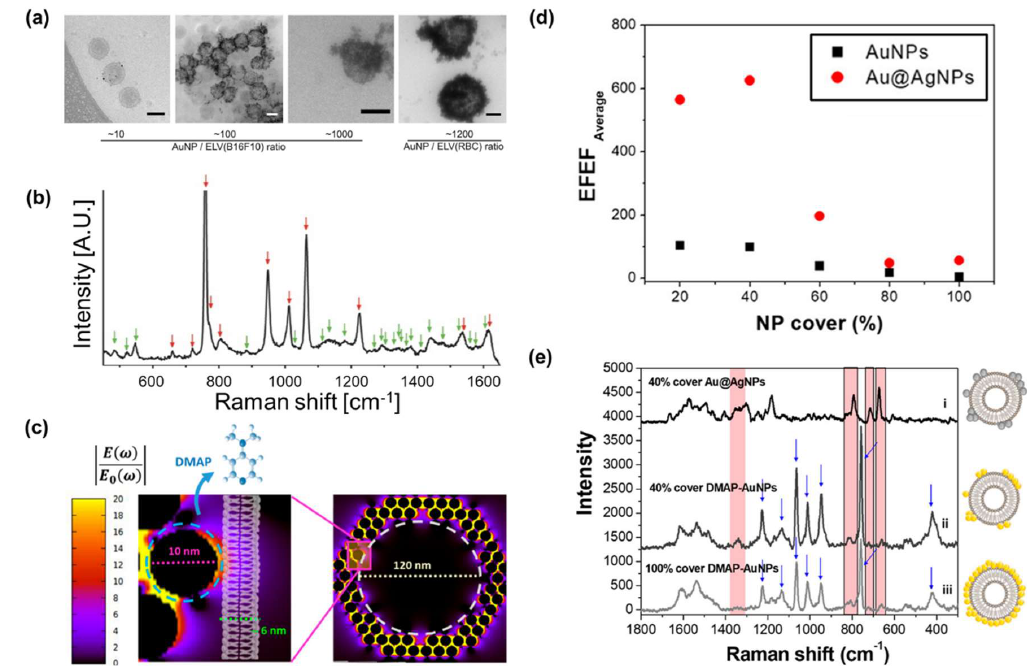
Figure 6. Positively charged particle-based EVs detection ( a ) TEM images of DMAP-AuNPs-coated EVs by each ratio. The scale bars represented 100 nm. ( b ) SERS measurements of DMAP-AuNP coated EVs. Red arrows indicate the DMAP-AuNP peaks, and green arrows indicate EV peaks. Ref. [56]. Copyright Wiley-VCH Verlag GmbH & Co. KGaA. Reproduced with permission ( c ) EM field enhancement results. The zoom-in image shows single DMAP-AuNP attached to the vesicle surface. The blue dashed line indicates DMAP molecules present area. ( d ) Theoretical relation between EV coverage ratio and EFEF before Ag shell-forming (black square) and after Ag shell formed (red dot). ( e ) SERS characterization of EVs coated with Ag shell-AuNPs or DMAP − AuNPs. (i) 40% coverage with Ag shell-AuNPs, (ii) 40% coverage with DMAP − AuNPs, and (iii) 100% coverage with DMAP − AuNPs. The blue arrows indicate the peaks of the DMAP. Adapted with permission from Ref. [57]. Copyright 2019 American Chemical